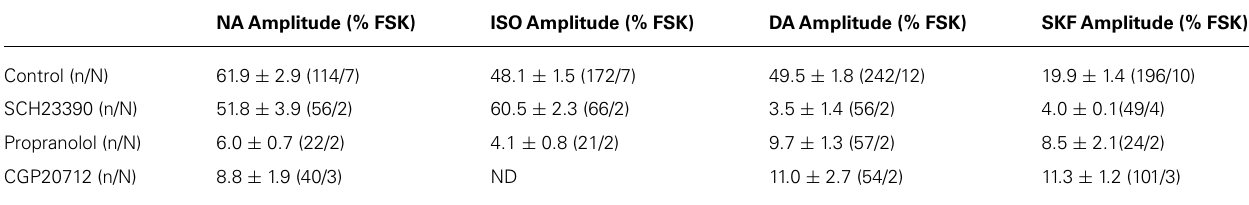
Table 2 | PKA stimulation involves beta1 adrenergic and D1/D5 dopaminergic receptors.